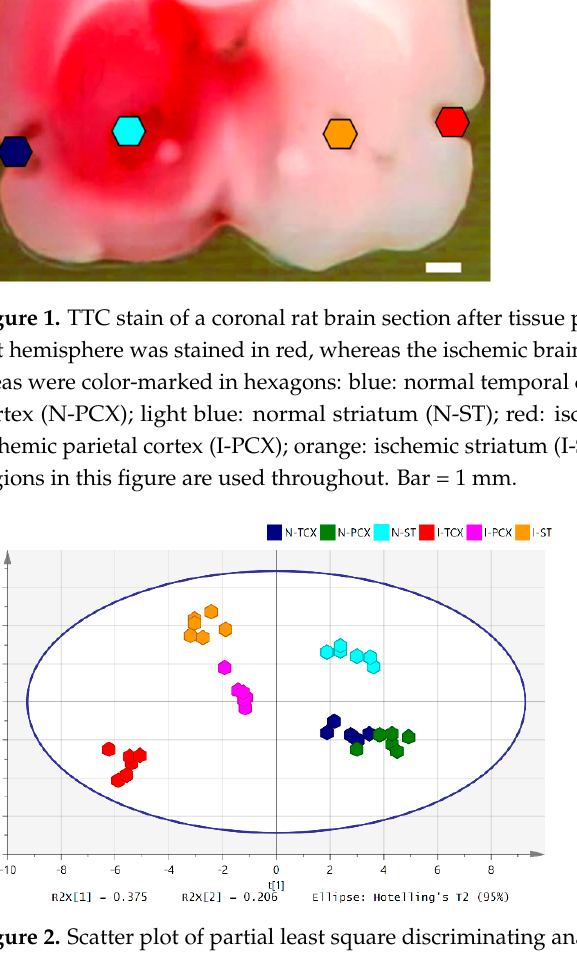
Figure 2. Scatter plot of partial least square discriminating analysis (PLS-DA) on phospholipids and sphingolipids in the ischemic and normal brain parenchyma. N = 6 at each sampling area. Color coding of the sampling regions follows that in Figure